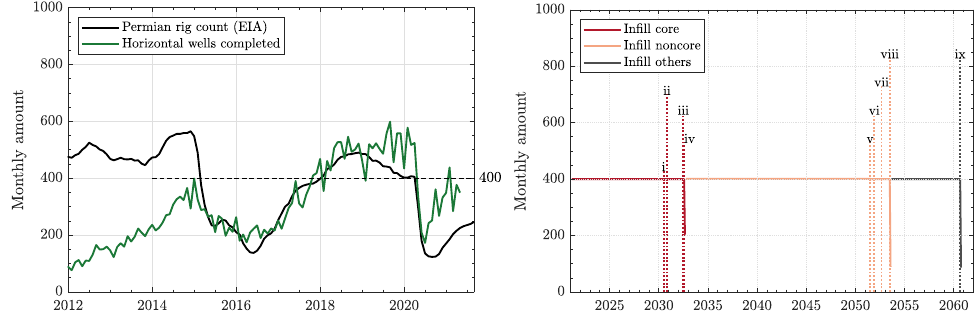
Figure 14. Historical number of completed wells and rig count from EIA and the future drilling programs in the Permian tight reservoirs at a constant drilling rate of 400 wells per month. The left panel shows the historical rig count from EIA, and the number of completed horizontal wells in the Permian Basin from Enverus. The roman numbers represent the last drilling date for each Permian region: (i) Delaware Bonespring Core, (ii) Midland Spraberry Core, (iii) Delaware Wolfcamp Core, (iv) Midland Wolfcamp Core, (v) Delaware Bonespring Noncore, (vi) Midland Spraberry Noncore, (vii) Delaware Wolfcamp Noncore, (viii) Midland Wolfcamp Noncore, and (ix)